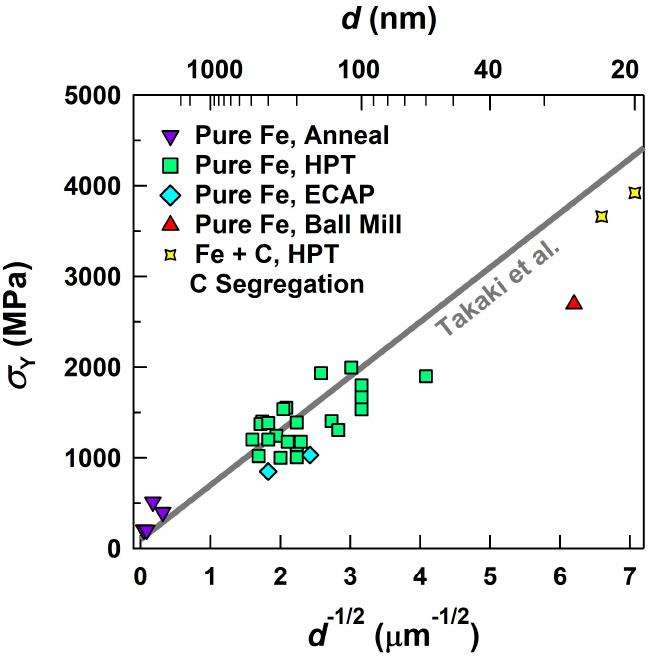
Figure 4. The Hall–Petch plot (yield stress, σ y , versus inverse square root of grain size, d ) for iron before and after severe plastic deformation by high-pressure torsion (HPT) and equal-channel angular pressing (ECAP) in comparison with the Hall–Petch relation suggested by Takaki et al. [159,160].